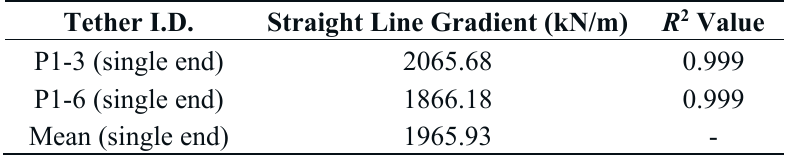
Table 4. Results of the eye splice extension tests (where R 2 value is the square of the Pearson product moment correlation coefficient).